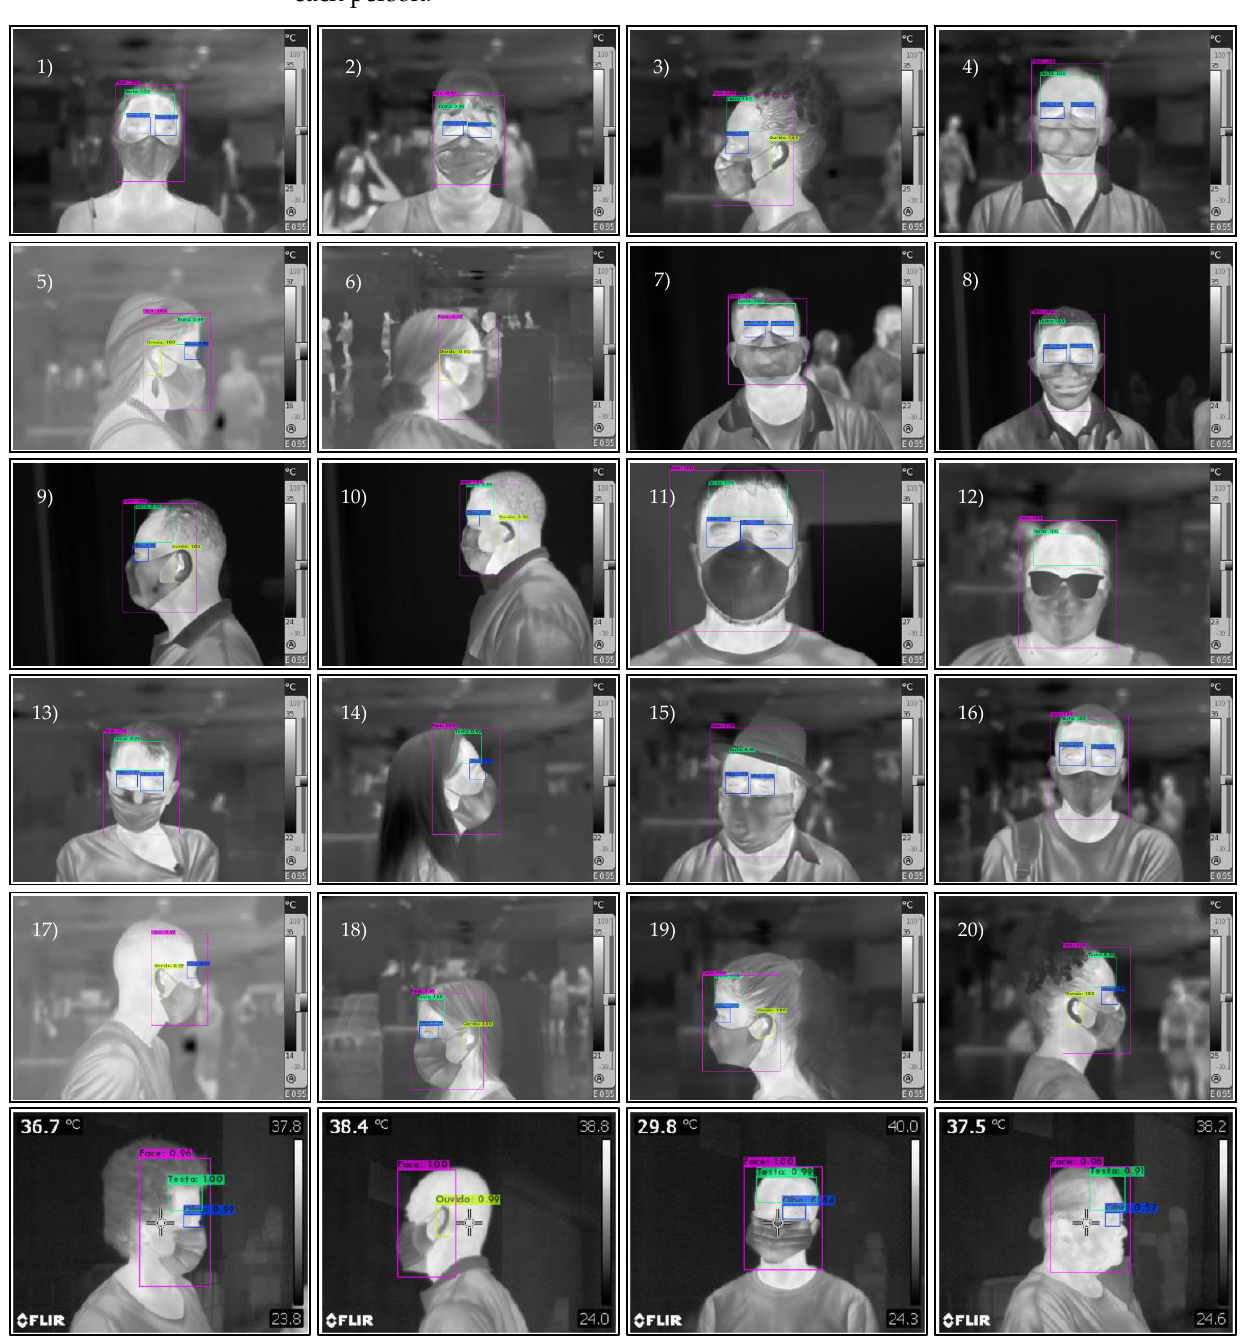
Figure 12. Images produced using the Testo-885 camera and analyzed by YOLO, with temperature estimated using Equation (3). Table 2. Estimated Volunteer Temperatures.